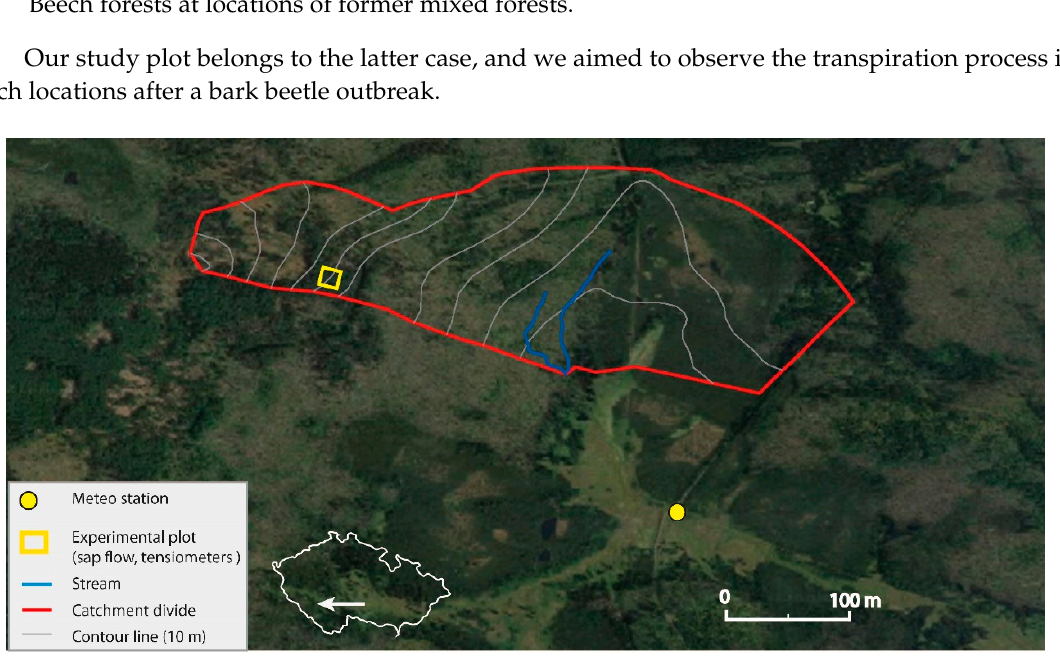
Figure 1. Location of the study site.